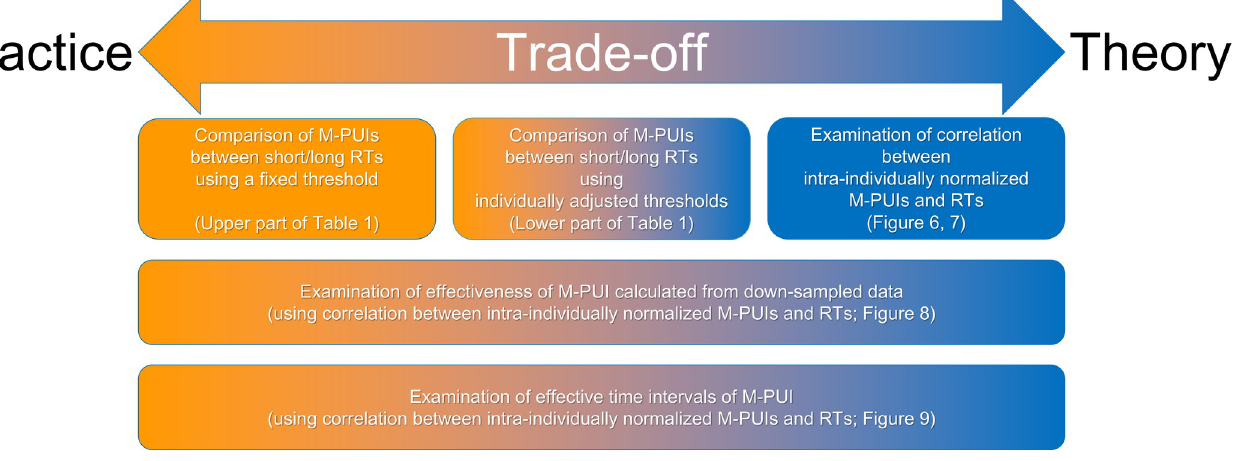
PLOS ONE | https://doi.org/10.1371/journal.pone.0256953 September 17,